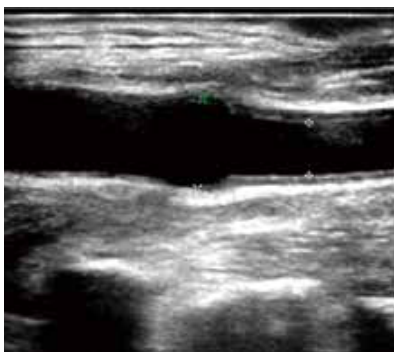
Figure 2 Cross-sectional examination of the right common carotid artery reveals a gap in the dissecting aneurysms.